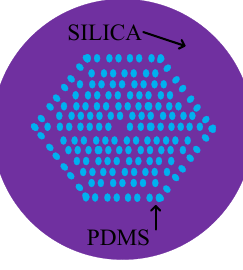
Figure 8. The schematic diagram of PCF filled with PDMS [41].